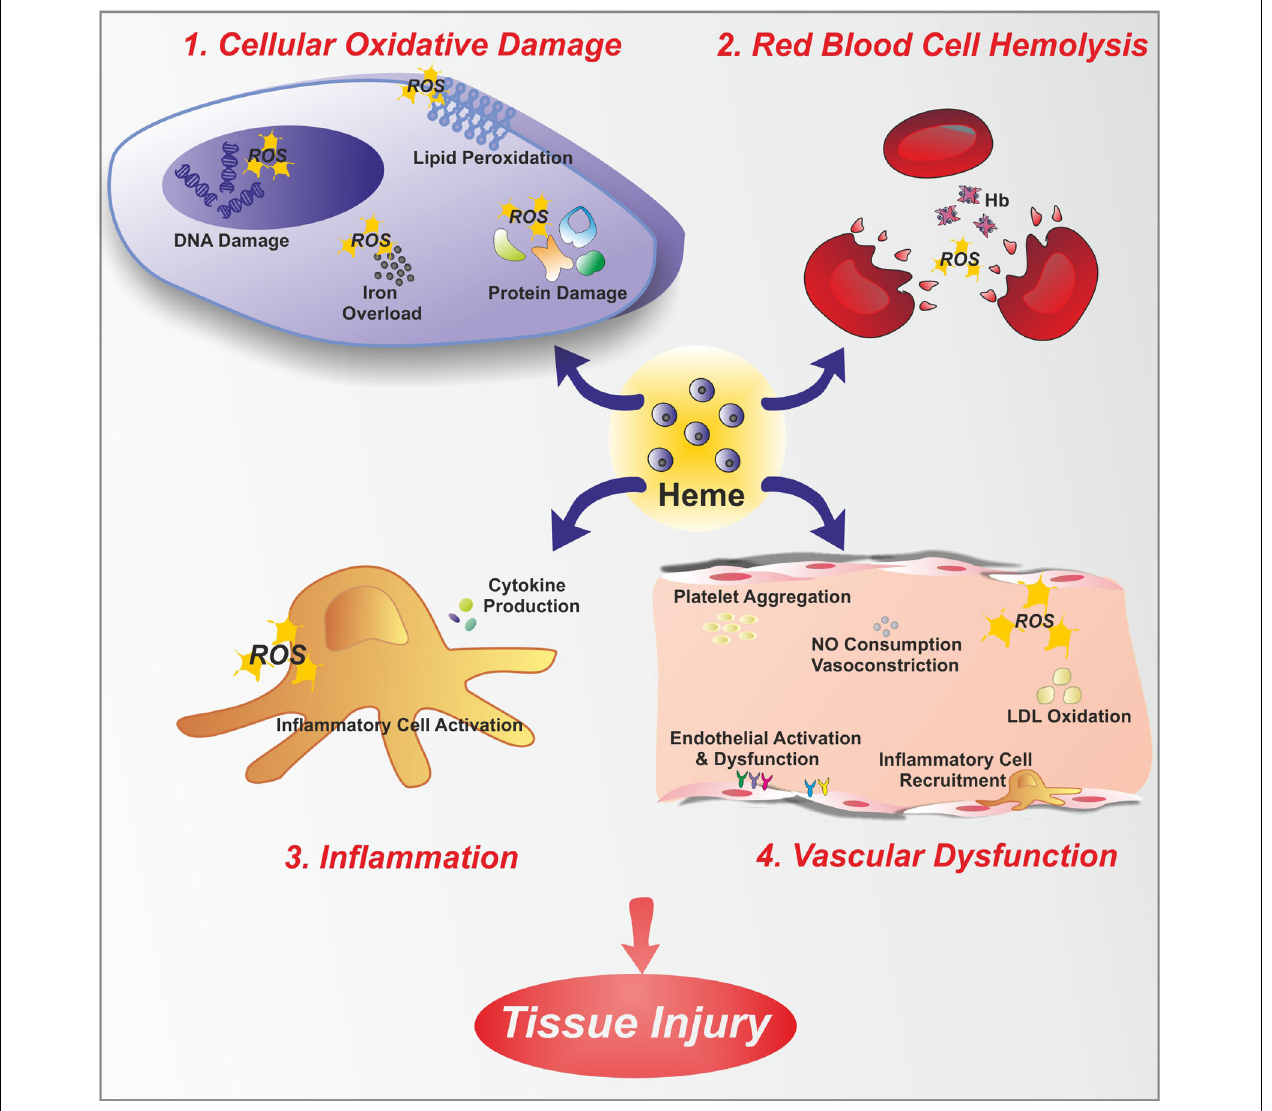
FIGURE 1 | Free heme toxicity. Free heme has potentially toxic properties due to the catalytic active iron atom it coordinates. Here, toxic effects of heme are depicted. Heme causes cellular oxidative damage (1) by promoting ROS formation, lipid peroxidation, DNA and protein damage. Additionally, heme is a source of iron. Therefore, heme overload leads to intracellular accumulation of iron, with further ROS generation. Heme is a hemolytic agent (2) , since it intercalates red blood cell membrane, thus favoring cell